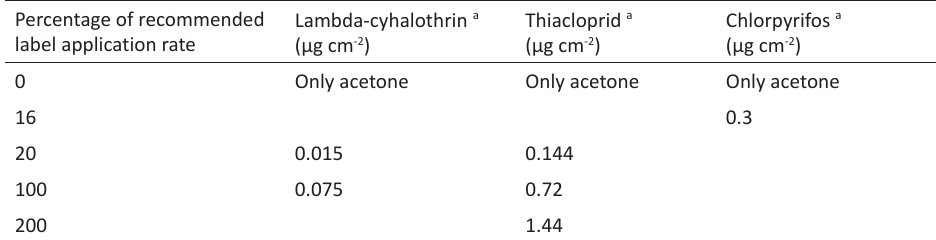
Table 2. Insecticide doses used in the bioassay Percentage of recommended label application